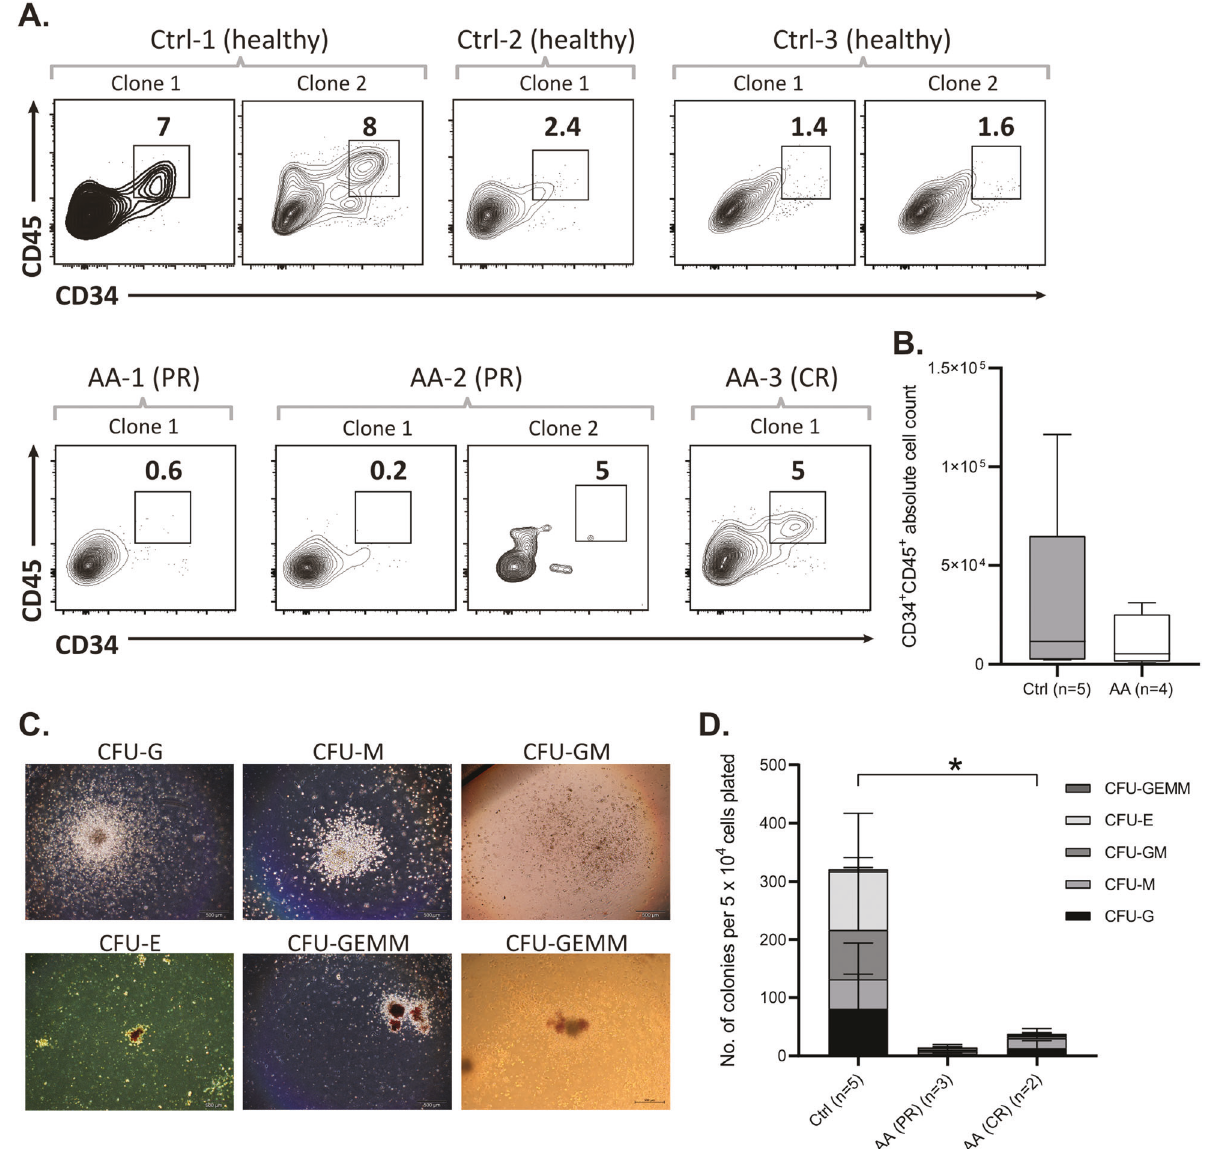
Fig. 3 AA and healthy-iPSCs differentiation into hematopoietic progenitors. A Representative images of fl ow cytometry analysis in percentages of CD34 and CD45 co-expression in healthy and AA cells at day 16 of hematopoietic differentiation. Ctrl-1 (clones 1 and 2), Ctrl-2 (clone 1) and Ctrl-3 (clones 1 and 2) represent healthy subjects; Patients samples AA-1 (clone 1) and AA-2 (clones 1 and 2) are partially responders (PR) to immunosuppression and AA-3 (clone 1) had a complete response (CR) to immunosuppression. B Box-plot showing the absolute cell count from the CD34 + CD45 + subset derived from Ctrl (3 subjects, 5 clones) and AA (3 subjects, 4 clones) iPSCs. The center line denotes the median value (50th percentile), while the box contains the 25th to 75th percentiles of dataset. The black whiskers indicate the minimum and maximum values. C Morphology of representative myeloid and erythroid colonies from a colony forming unit (CFU) assay: CFU- G (granulocytes) CFU-M (macrophages), CFU-GM (granulocytes and macrophages), CFU-E (erythrocytes) and, CFU-GEMM (granulocytes, erythrocytes, monocytes, megakaryocytes). Scale bars, 500 μ m. D Qualitative and quantitative analysis of hematopoietic colonies derived from healthy (3 subjects, 5 clones) and AA-iPSC (3 subjects, 5 clones). Data is presented as mean of experimental triplicates ±